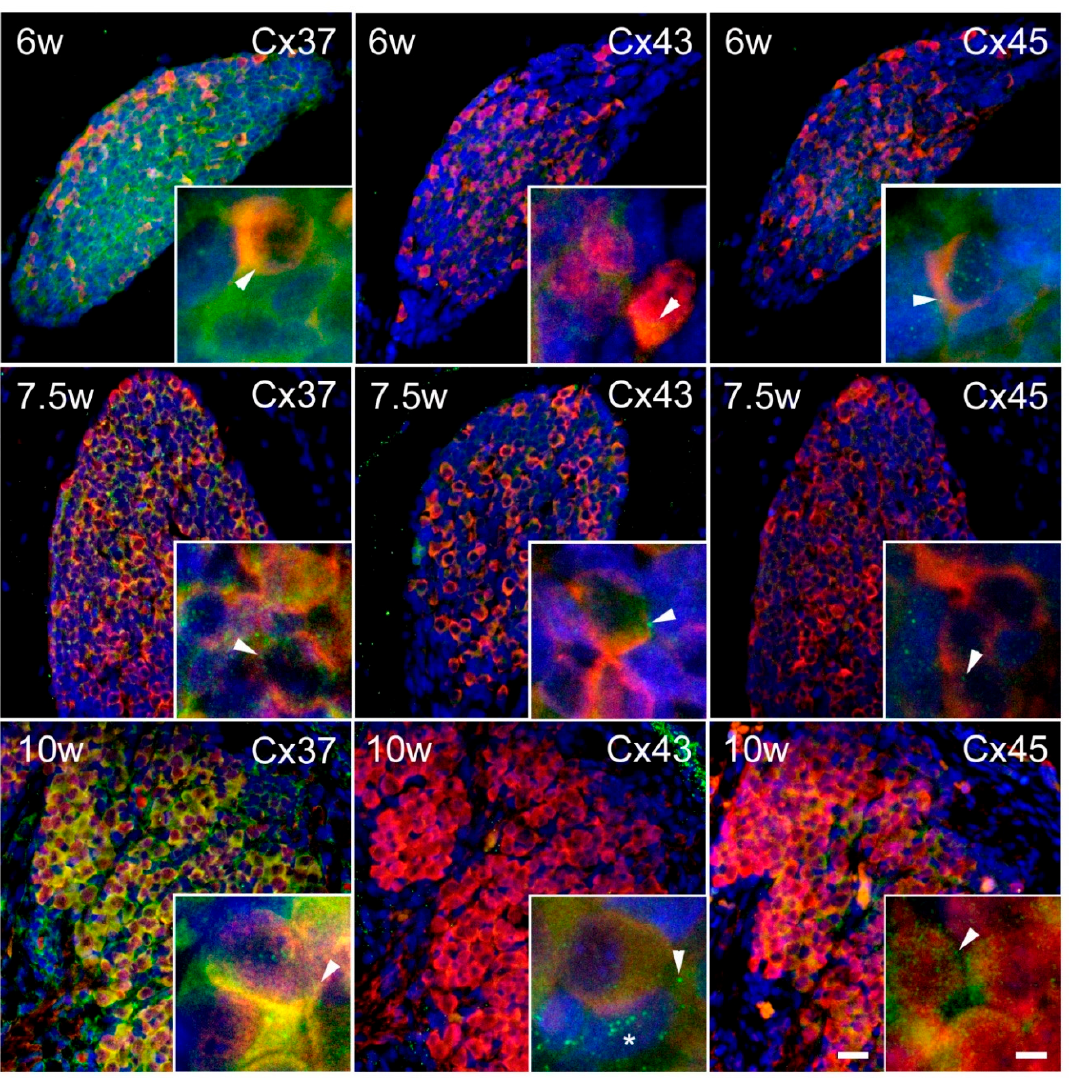
Figure 5. Expression of Cxs 37, 43, and 45 in the dorsal root ganglia (DRG) of the human conceptuses. Thoracic segments of the SC of 6, 7.5, and 10 week-old human conceptuses were stained for Cx37, Cx43, and Cx45 (green), and PGP9.5 (red).DRG are presented on photomicrographs. Objective magnification—10 × (scale bar = 80 µ m); insets—100 × (scale bar = 8 µ m). Arrowheads are pointing to the yellow granular pattern of Cx / PGP9.5 co-localization in the cytoplasm of developing primary sensory neurons. Asterisk—non-neuronal cell, presumably glia, immunoreactive for Cx43.